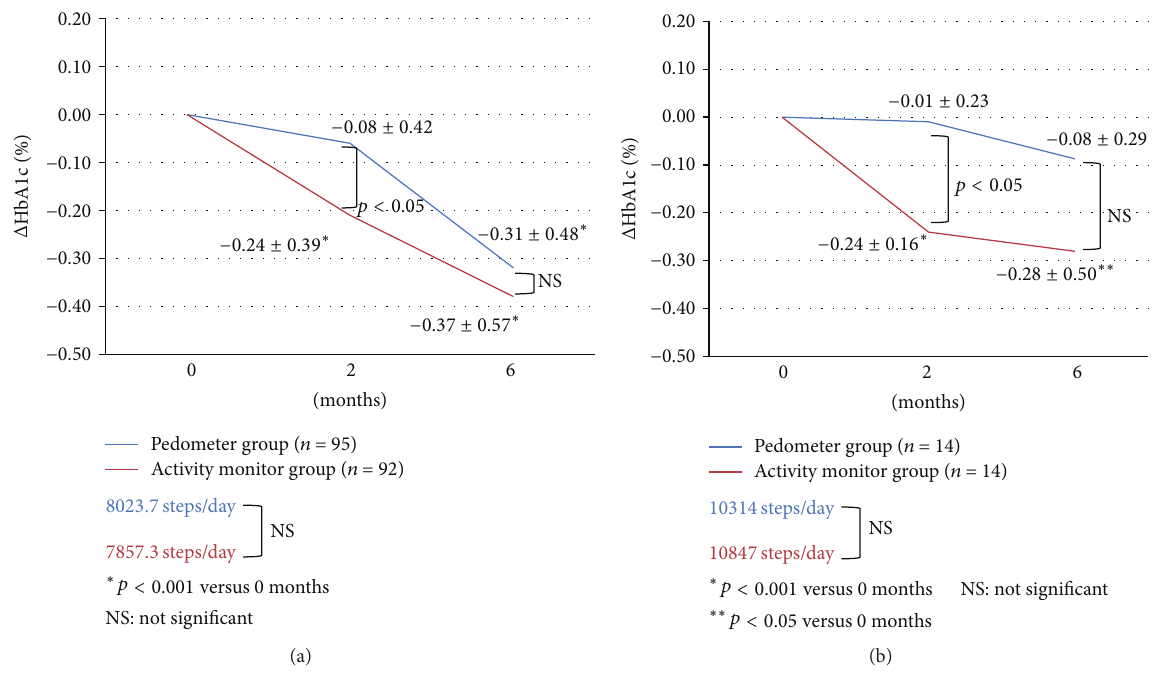
Figure 4: (a) Changes in HbA1c level after daily walking exercise for 2 and 6 months in the pedometer and activity monitor groups and all 187 patients. (b) Changes in HbA1c level after daily walking exercise for 2 and 6 months in 28 patients of the pedometer and activity monitor groups who achieved their goals and recorded no changes in medications throughout the